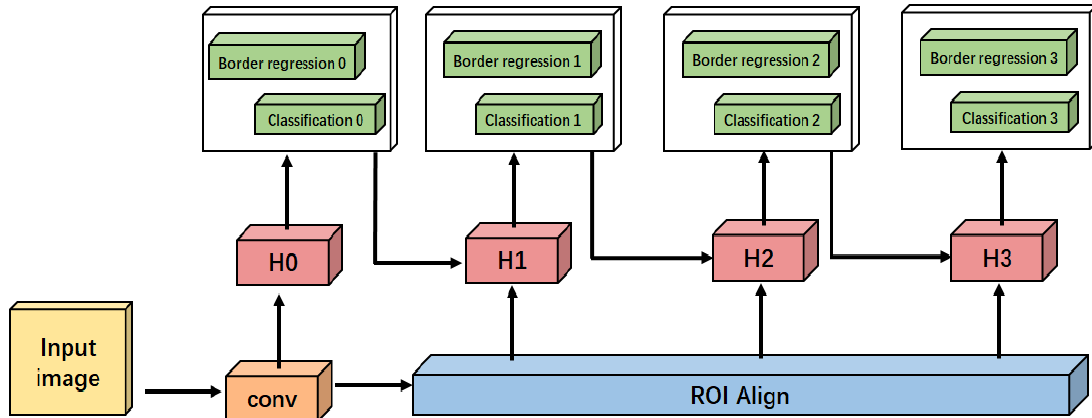
Figure 10. The improved framework of cascade R-CNN.